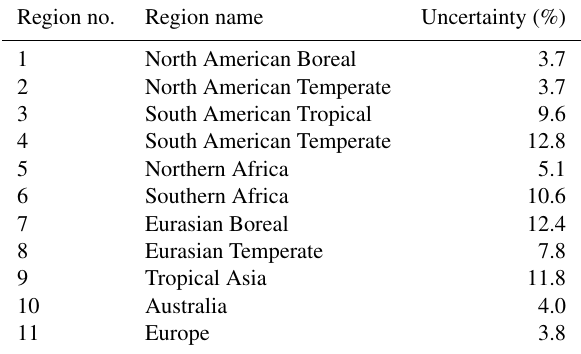
Table 3. Annual uncertainty estimates over the TransCom land re- gions. The uncertainty estimates were mass weighted values of un- certainty estimates of countries that fall in the regions. Country un- certainty estimates were estimated using the method described (An- dres et al., 2014). The values were reported as the 2 σ uncertainty. Region